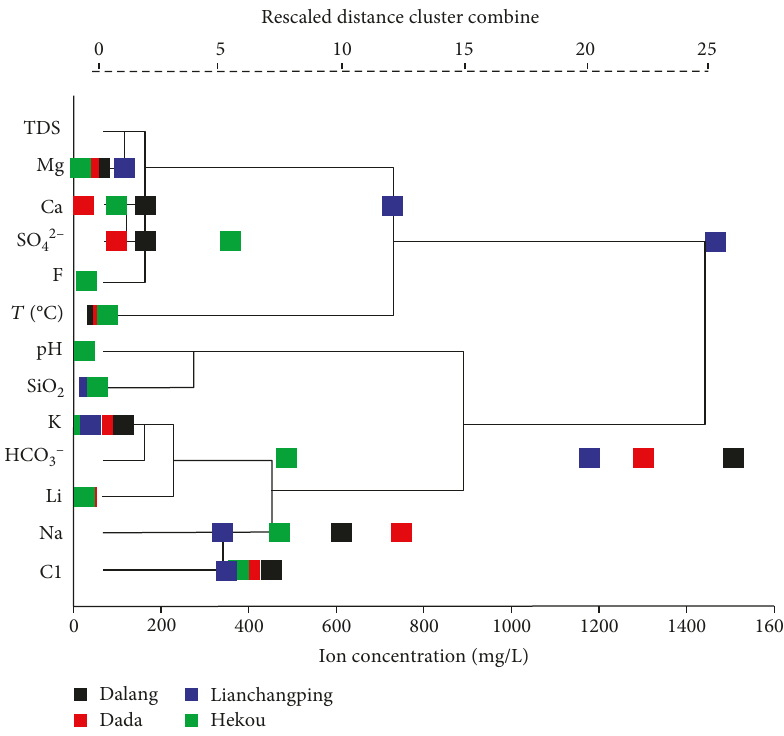
Figure 2: The dendrogram showing three clusters of ingredient concentrations of four hot springs. Table 2: Hydrochemical ingredient content proximity matrix of 4 hot spring waters calculated by